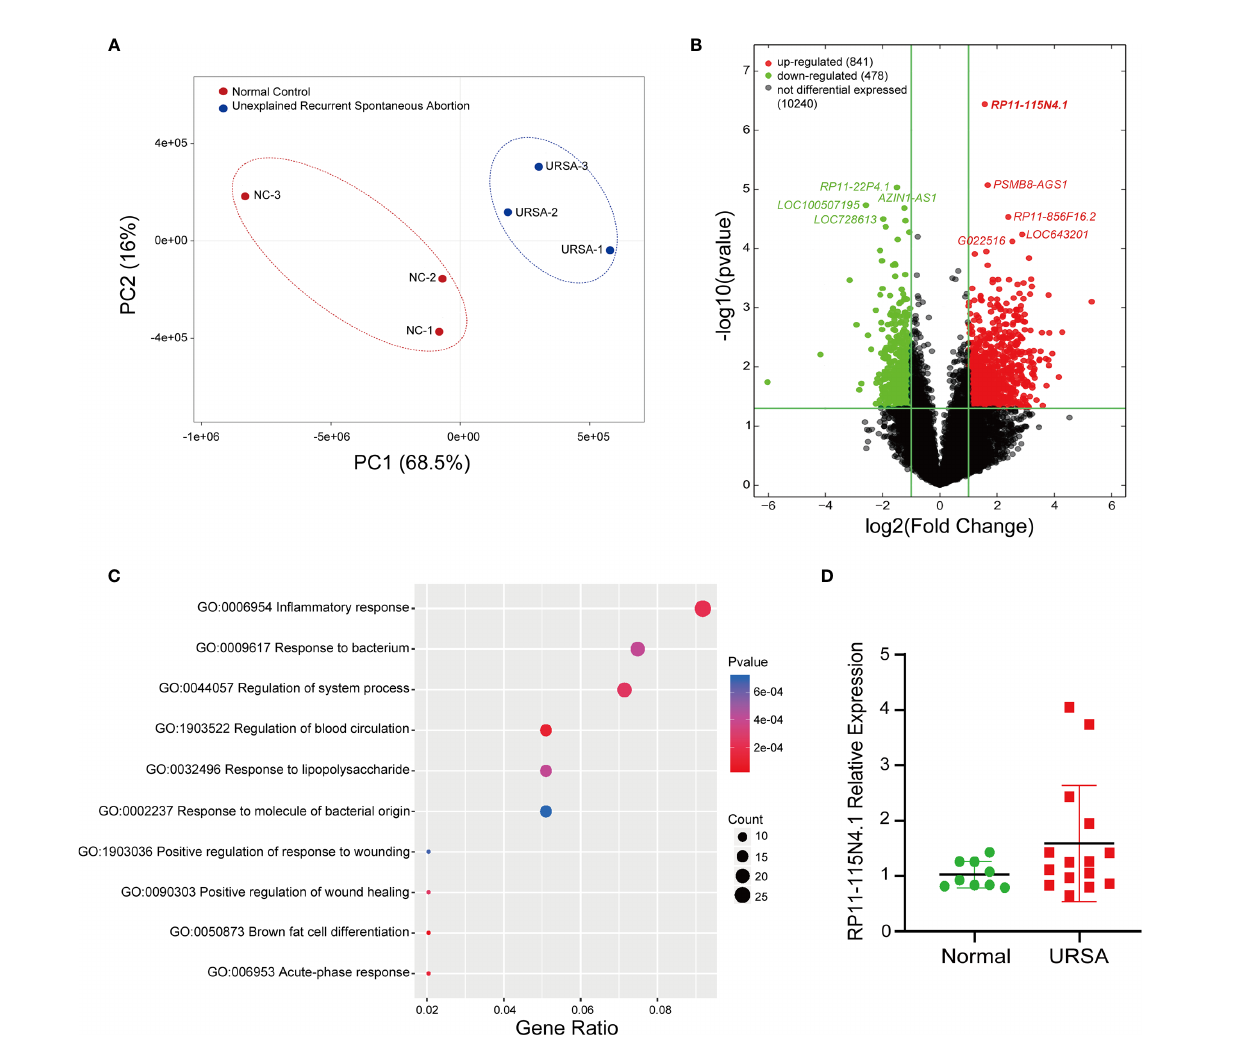
FIGURE 1 | RP11-115N4.1 Expression Signi fi cantly Increased in PBMC of URSA. (A) Cluster map of URSA samples and normal controls (3 vs. 3). (B) Volcano plot described that the differentially expressed lncRNAs in URSA (Fold change ≥ 2, P < 0.05). (C) GO analysis indicated that in fl ammatory response pathway was signi fi cantly enriched in URSA. (D) Quantitative RT-PCR analysis of RP11-115N4.1 level in URSA blood samples (URSA, N = 15) and normal woman blood samples (Normal, N = 9). GAPDH was used as the internal